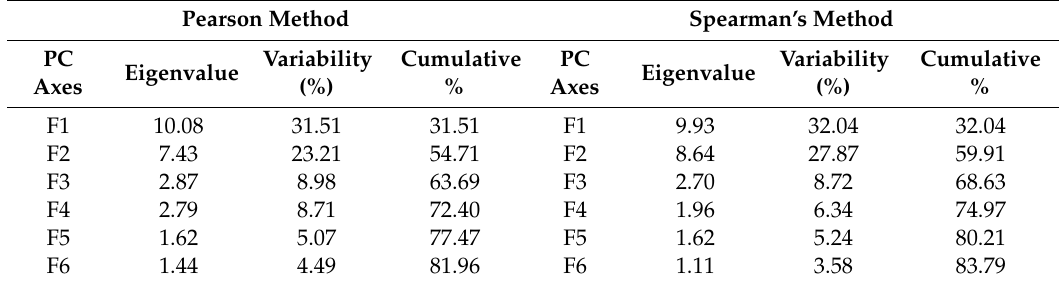
Table 2. Eigenvalue with variability and cumulative variability for selected PC axes from Pearson and Spearman’s method.